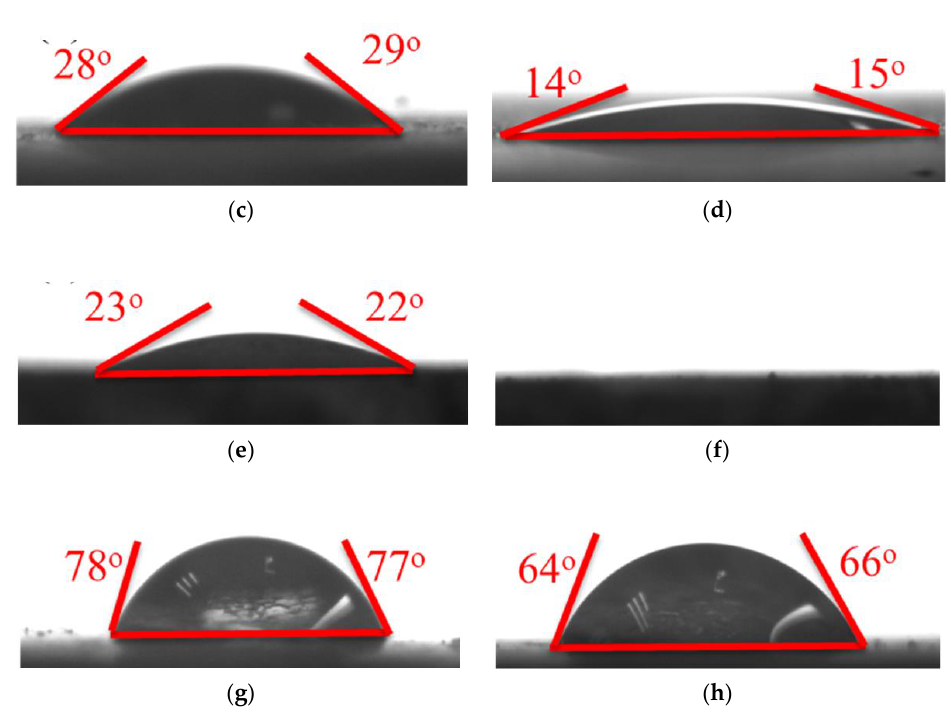
Figure 12. The contact angles at 0 and 10 min: ( a ) as-receive rubber; ( b ) treated rubber; ( c ) C0 at 0 min; ( d ) C0 at 10 min; ( e ) UR5 at 0 min; ( f ) UR5 at 10 min; ( g ) TR5 at 0 min; and ( h ) TR5 at 10 min.